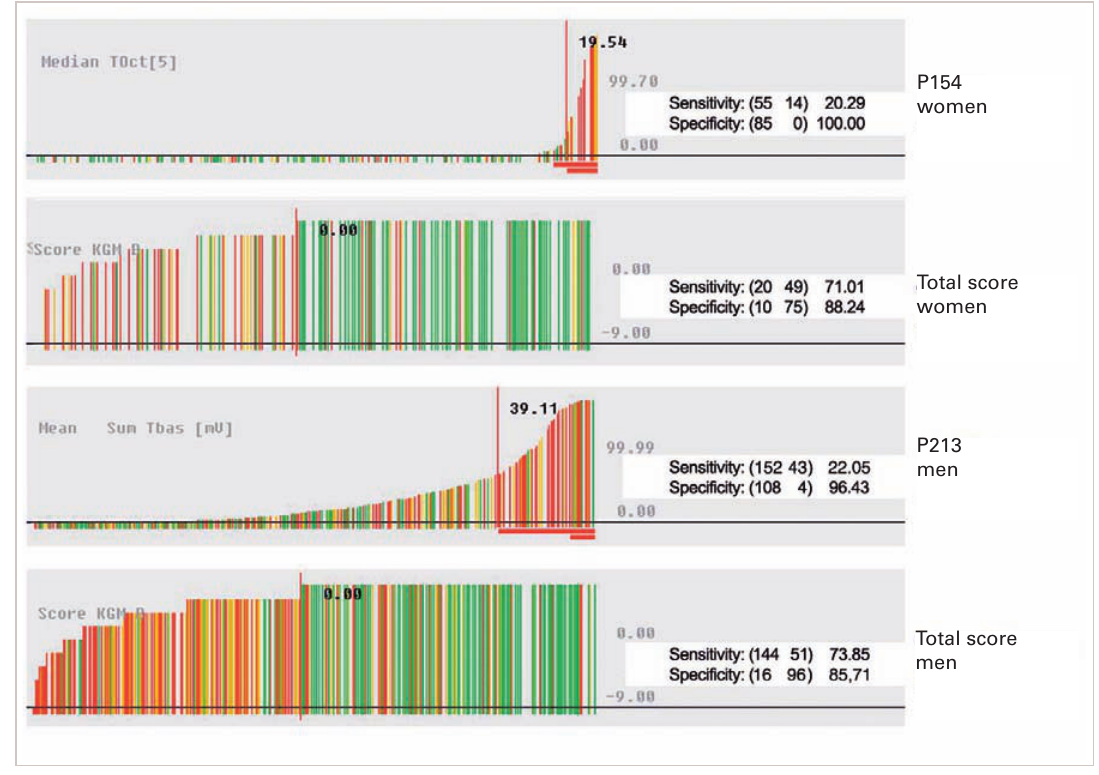
The distribution of measured values is given for one exemplary variable measured in women (above) and men (below) and for the global score (retrospective cohort). Values are sorted from the lowest to the highest. The ordinate corresponds to the measured values. Lowest and highest measured values are indicated on the right in grey. One vertical line is drawn for each patient. Green lines indicate patients without significant coronary artery stenoses. Yellow lines indicate patients with one vessel disease. Red lines indicate patients with two or three vessel disease. The sensitivity and specificity for each individual variable are given on the right side. The numbers in parentheses indicate false negatives (above left), true positives (above right), true negatives (below left), and false positives (below right). Red horizontal bars indicate pathological ranges for men (upper bar) and women (lower